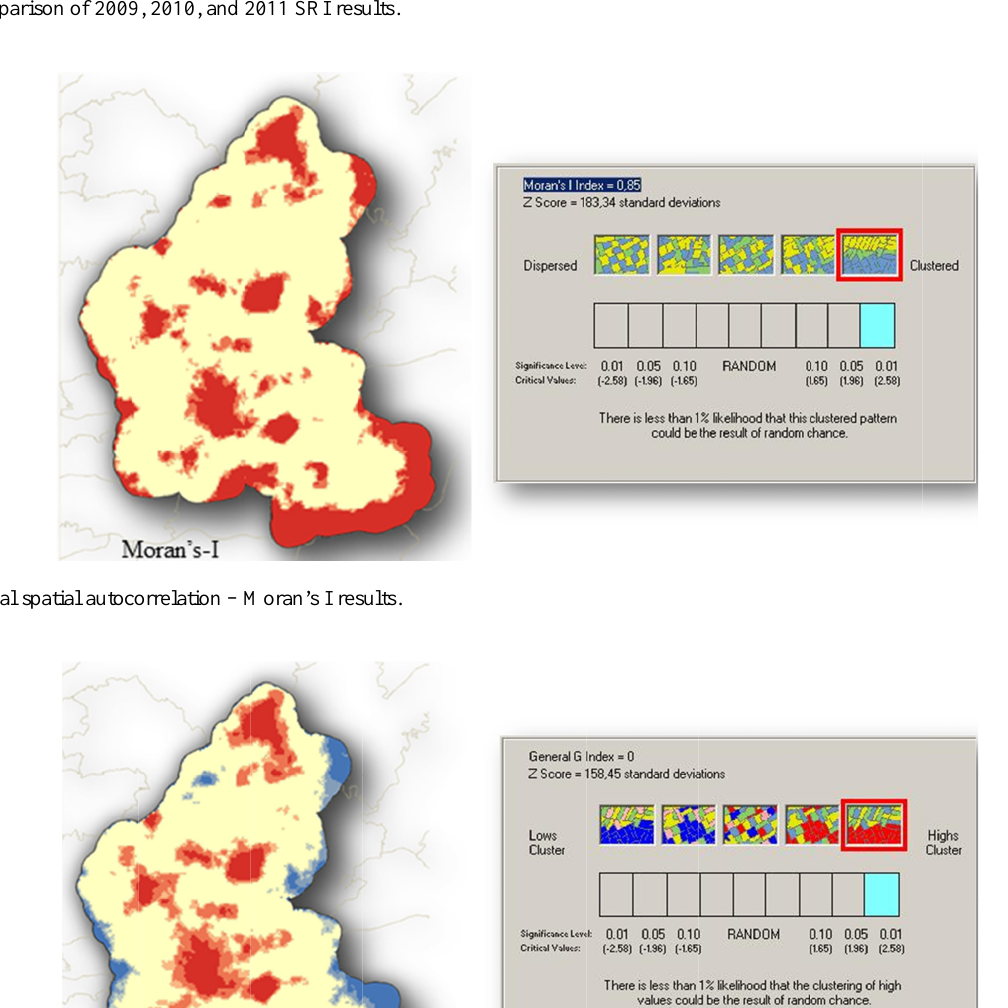
Fig. 4. Comparison of 2009, 2010, and 2011 SRI results.